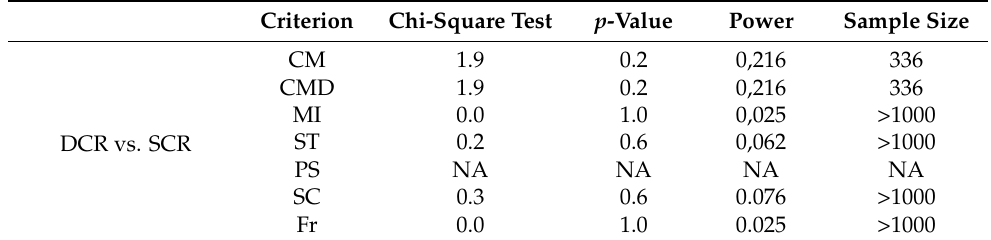
Table 5. The results of a Log-rank test for comparing long-term results in a group without any biological factors of caries risk (Group 1) between DCR and SCR restoration techniques.